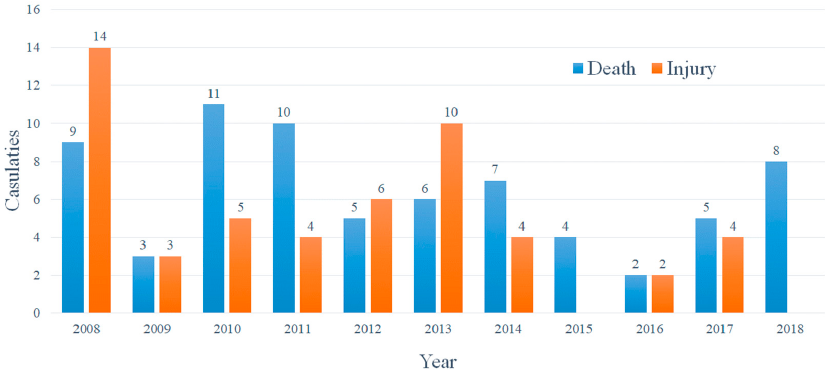
Figure 1. Statistics for injuries and deaths in catastrophic and fatal occupational accidents occurring in confined spaces from 2008 to 2018 in Taiwan.